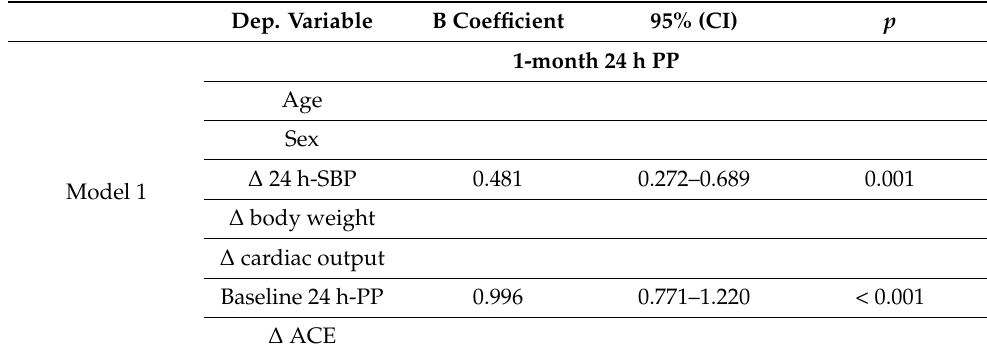
Table 3. Role of several factors, including RAAS components, on changes in arterial stiffness markers in patients without antihypertensive